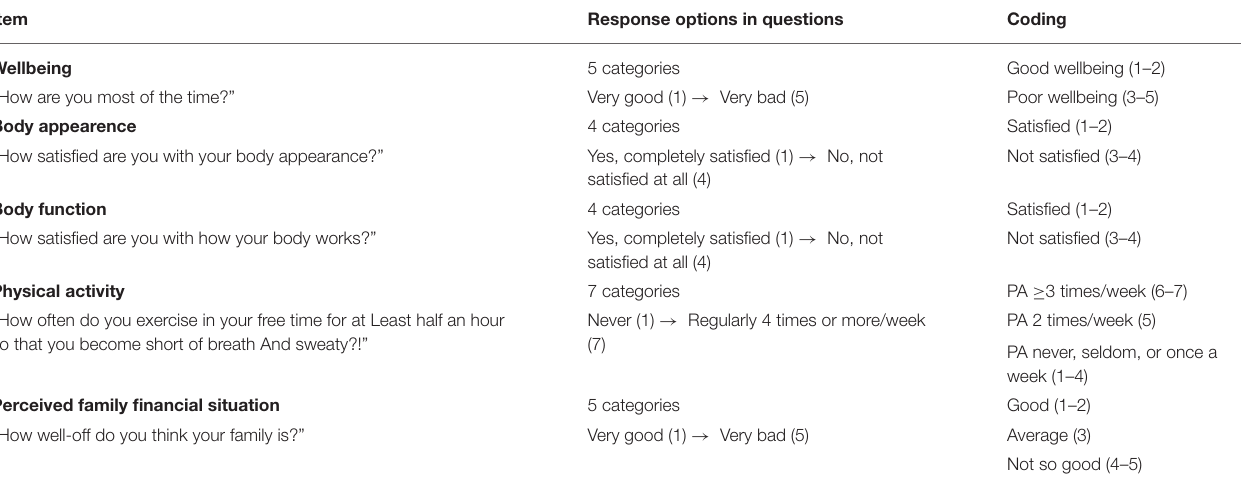
TABLE 1 | Variables included in the logistic regression with wellbeing as the dependent